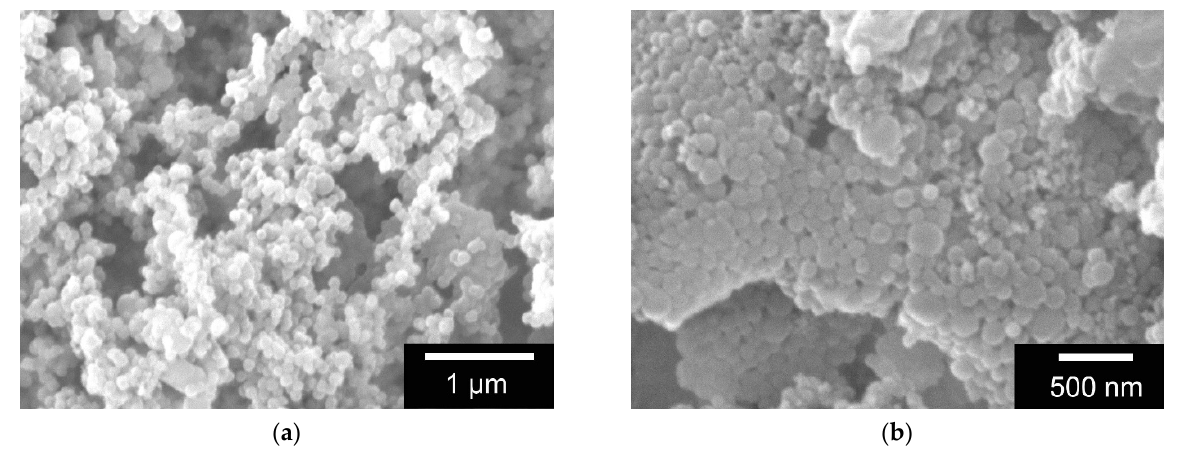
Figure 2. ESEM images of GNP with ( a ): 1% w / v FITC-protein A and ( b ): 2% w / v FITC-protein A. Images taken with FEI Quanta 250 FEG at 12 kV acceleration voltage, all samples were sputter coated (JEOL, JFC-1200) with a 25 nm Gold layer.